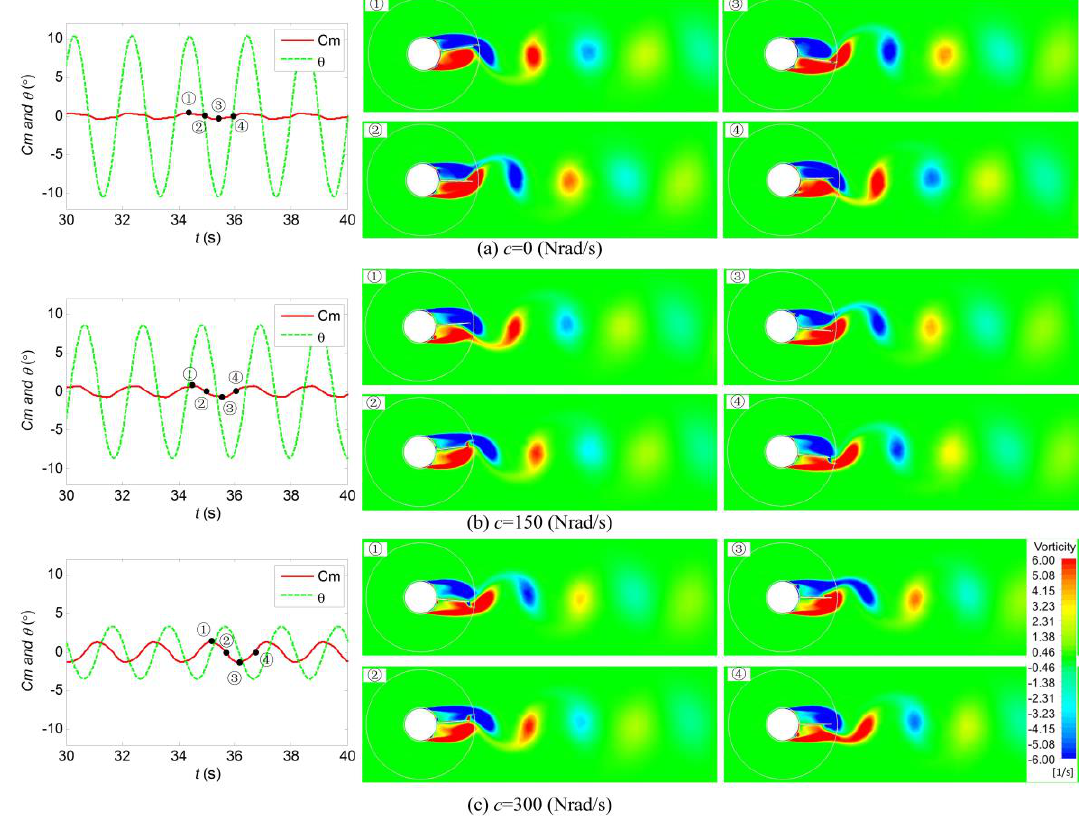
Figure 13. Wake structures for different system damping: ( a ) c = 0 Ns/rad, ( b ) c = 150 Ns/rad, and ( c ) c = 300 Ns/rad.